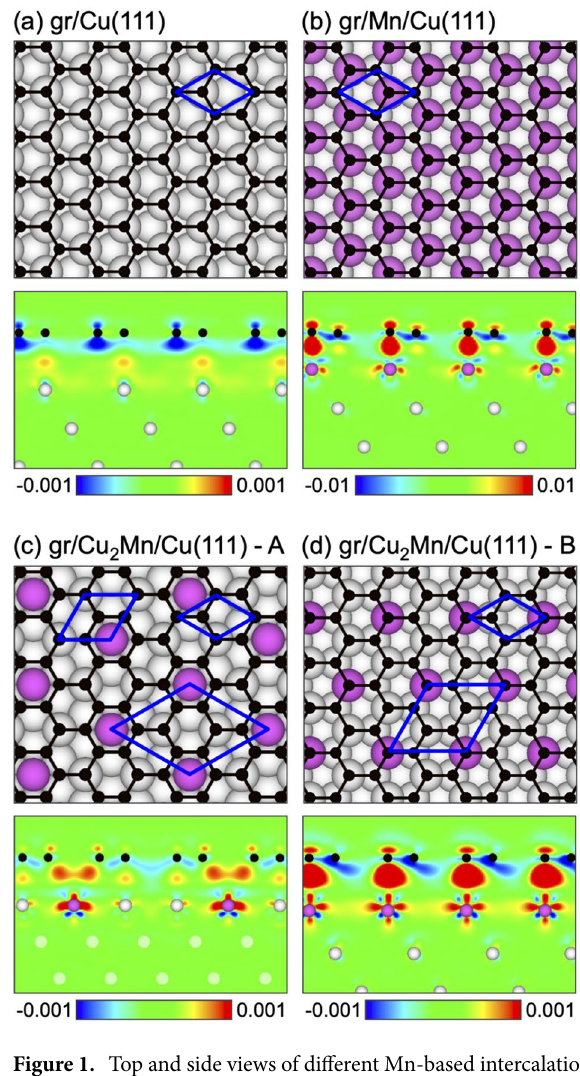
0.001 e / Å 3 ), green −